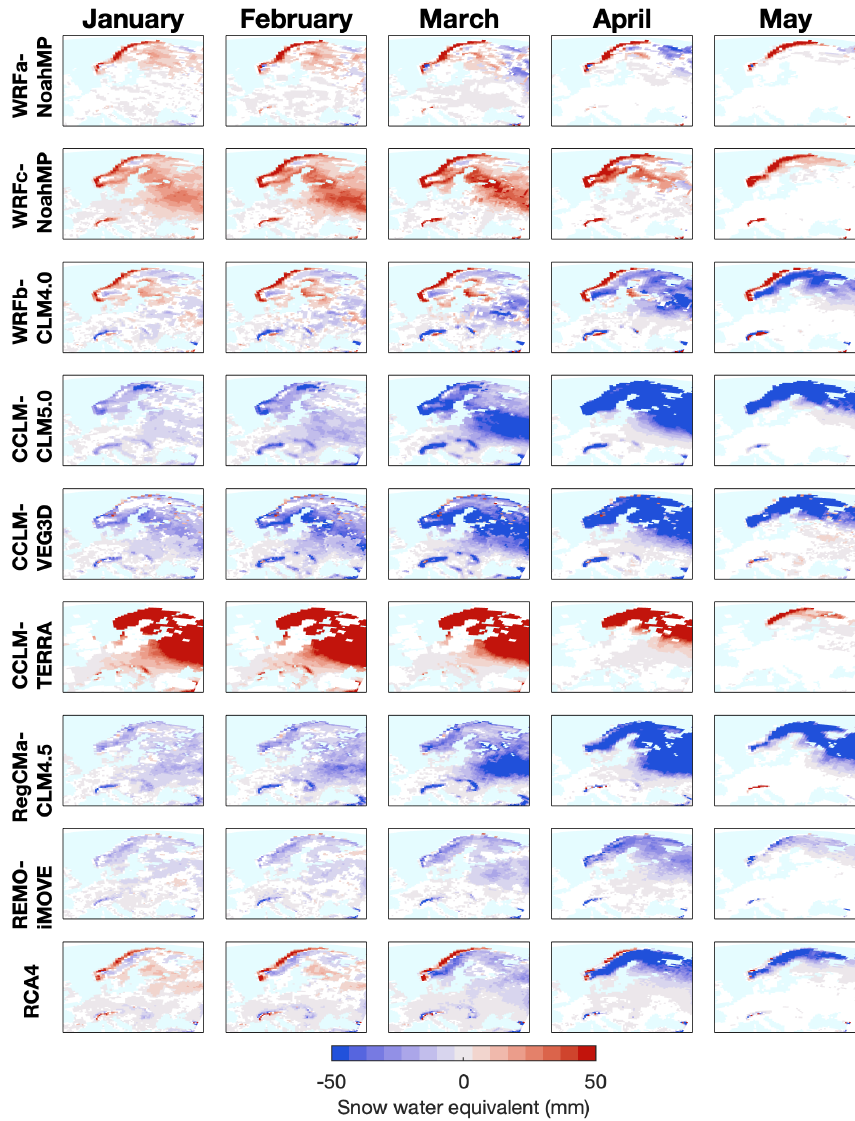
Figure 3. Impact of afforestation (FOREST − GRASS) on snow water equivalent (SWE) simulated by the CORDEX FPS LUCAS models. White spaces show grid boxes that are not statistically significant at the 95% confidence